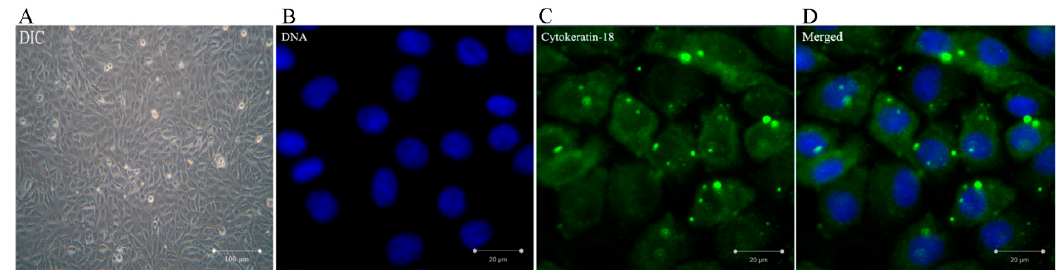
Figure 1. The culture of bovine mammary epithelial cells (BMECs) and the immunofluorescence of cytokeratin-18 in vitro. It was proven that the cells were bovine mammary epithelial cells. ( A ) Morphology of BMECs. ( B ) The BMECs were inoculated into the cell slide, and the keratin 18 immunofluorescence staining was performed. A green positive reaction was observed around the blue nucleus. Detection of nuclei by 4’, 6-diamidino-2-phenylindole (DAPI) staining (blue). ( C ) Detection of cytokeratin-18 protein (green) by immunofluorescence staining. ( D ) Merged picture of ( B ) and ( C